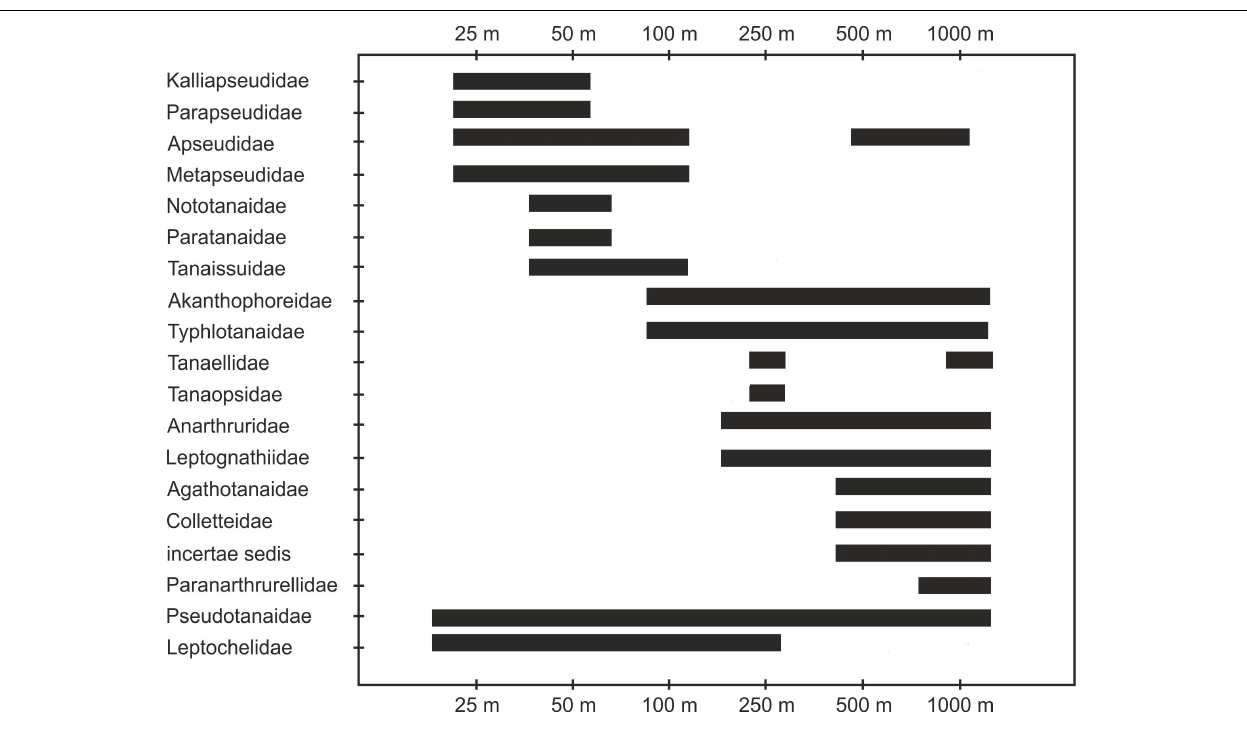
FIGURE 7 | Depth range of tanaidacean families recorded in the Gulf of